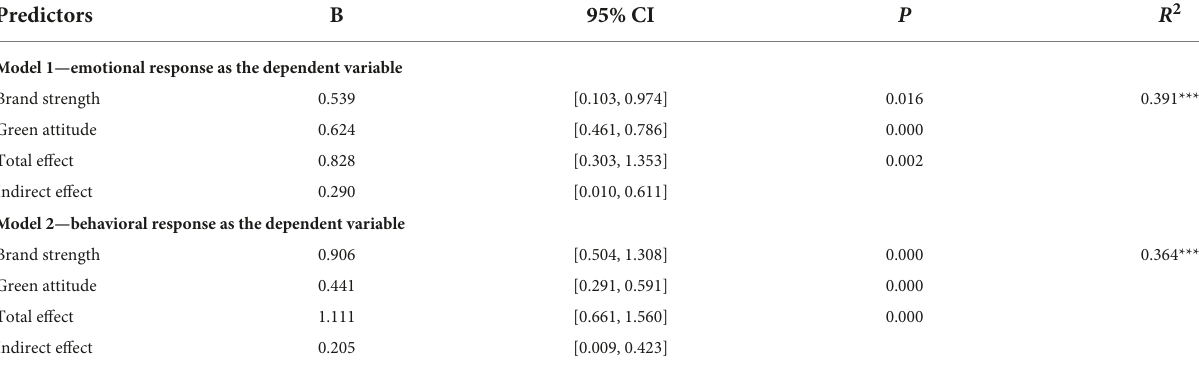
TABLE 3 Results of the mediation analysis with consumption responses as the dependent variables, brand strength as the independent variable, and green attitude as the mediator.